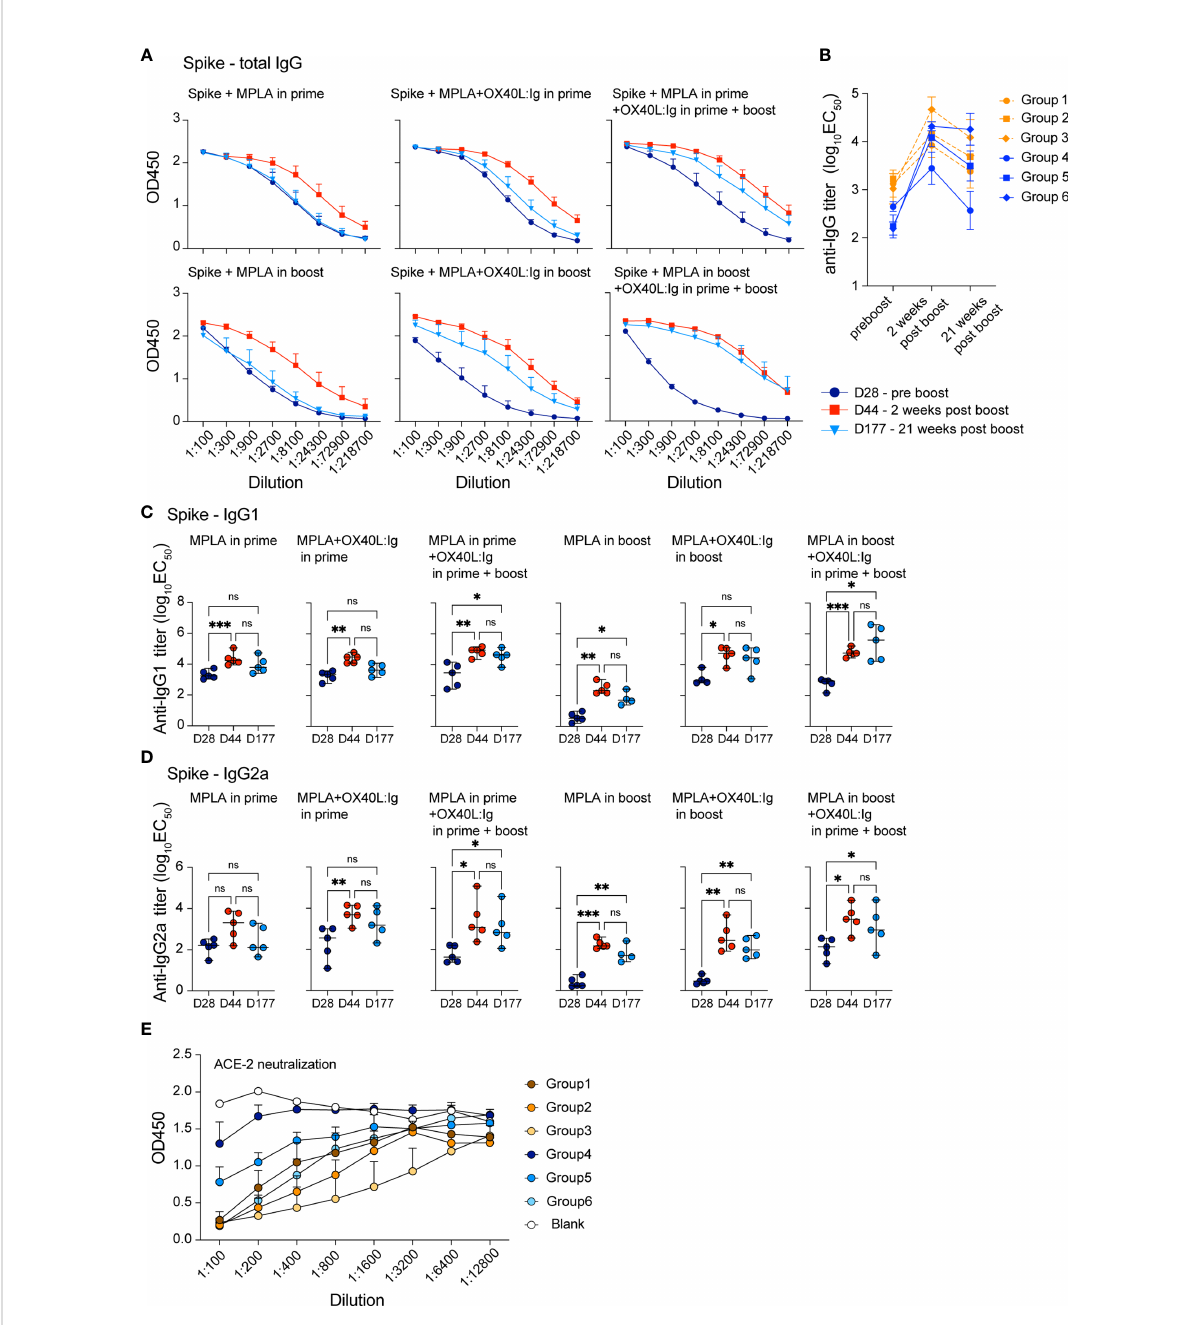
FIGURE 3 OX40 agonists increase the magnitude and longevity of spike vaccine-speci fi c antibodies. Experimental scheme and groups are outlined in Figures 2A, B. Mice were bled on day 28, prior to the boost (indigo circles); day 44, 2 weeks post-boost (red squares); day 177, 21 weeks post-boost (blue triangles), and antibody titers to the spike protein were assessed. (A) shows total IgG titers against the spike protein. Values on the y-axis indicate absorbance measured at 450 nm. D=day (B) shows the log 10 (EC 50 ) titers of all groups at each timepoint pre boost, two weeks post boost and 21 weeks post boost fi c antibodies and (D) shows the log fi c antibodies. (C) shows the log 10 (EC 50 ) titers of IgG1 isotype spike-speci 10 (EC 50 ) titers of IgG2a isotype spike-speci C and D, one-way ANOVA with Tukey ’ s multiple-comparisons test. *P<0.05, **P<0.01, ***P<0.001, ns, not signi fi cant. (E) Data from the neutralization assay performed using the ACE2-Fc protein and supernatants from all groups 7 weeks post boost. All samples were diluted 1:100 and serially diluted 1:3 or 1:4 eight times in the assay and the serial dilutions are indicated by connecting